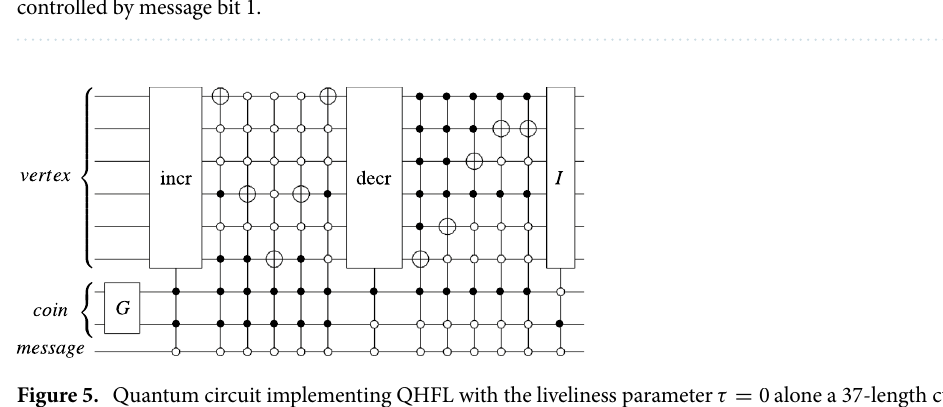
2 alone a 37-length cycle =